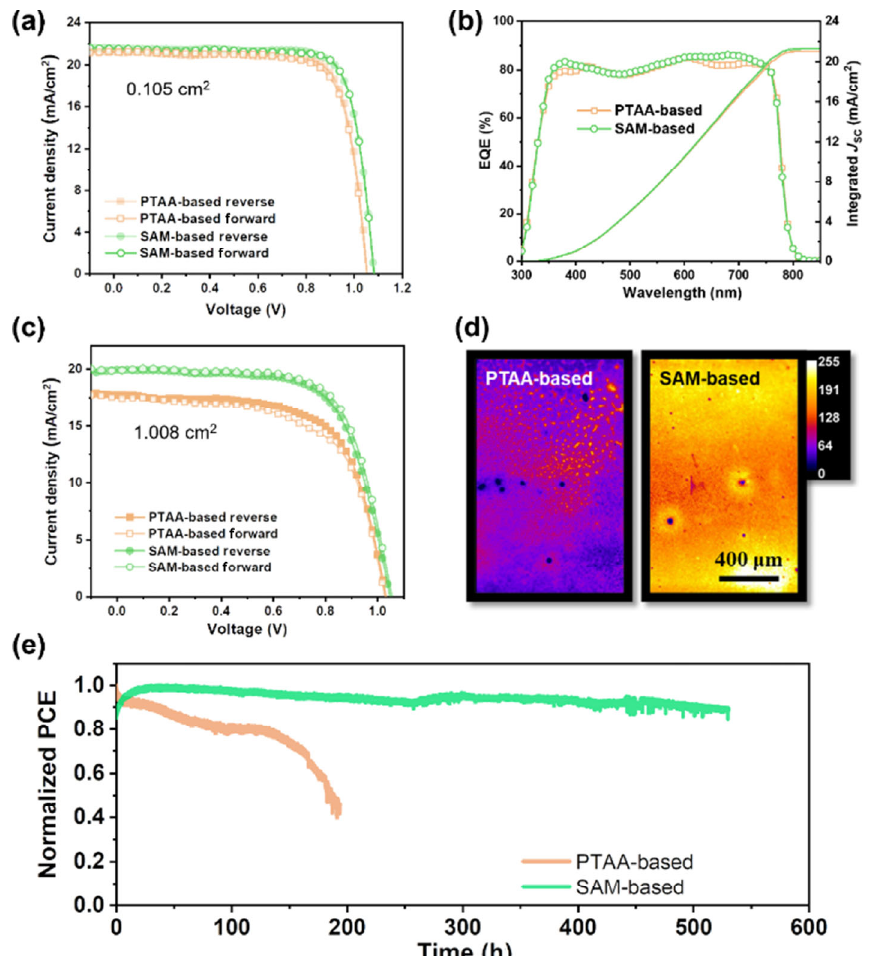
Figure 5 (a) J–V characteristics of PTAA-based PVSCs fabricated by blade-coating with an active area of 0.105 cm 2 . (b) The EQE and integrated J SC of PTAA- and SAM-based PVSCs. (c) J–V characteristics of SAM-based PVSCs fabricated by blade-coating with an active area of 1.008 cm 2 . (d) EL imaging of PTAA- and SAM-based PVSCs. (e) MPPT of PTAA- and SAM-based PVSCs under AM 1.5G illumination in a N 2 filled Table 1 Photovoltaic parameters of PTAA- and SAM-based PVSCs with